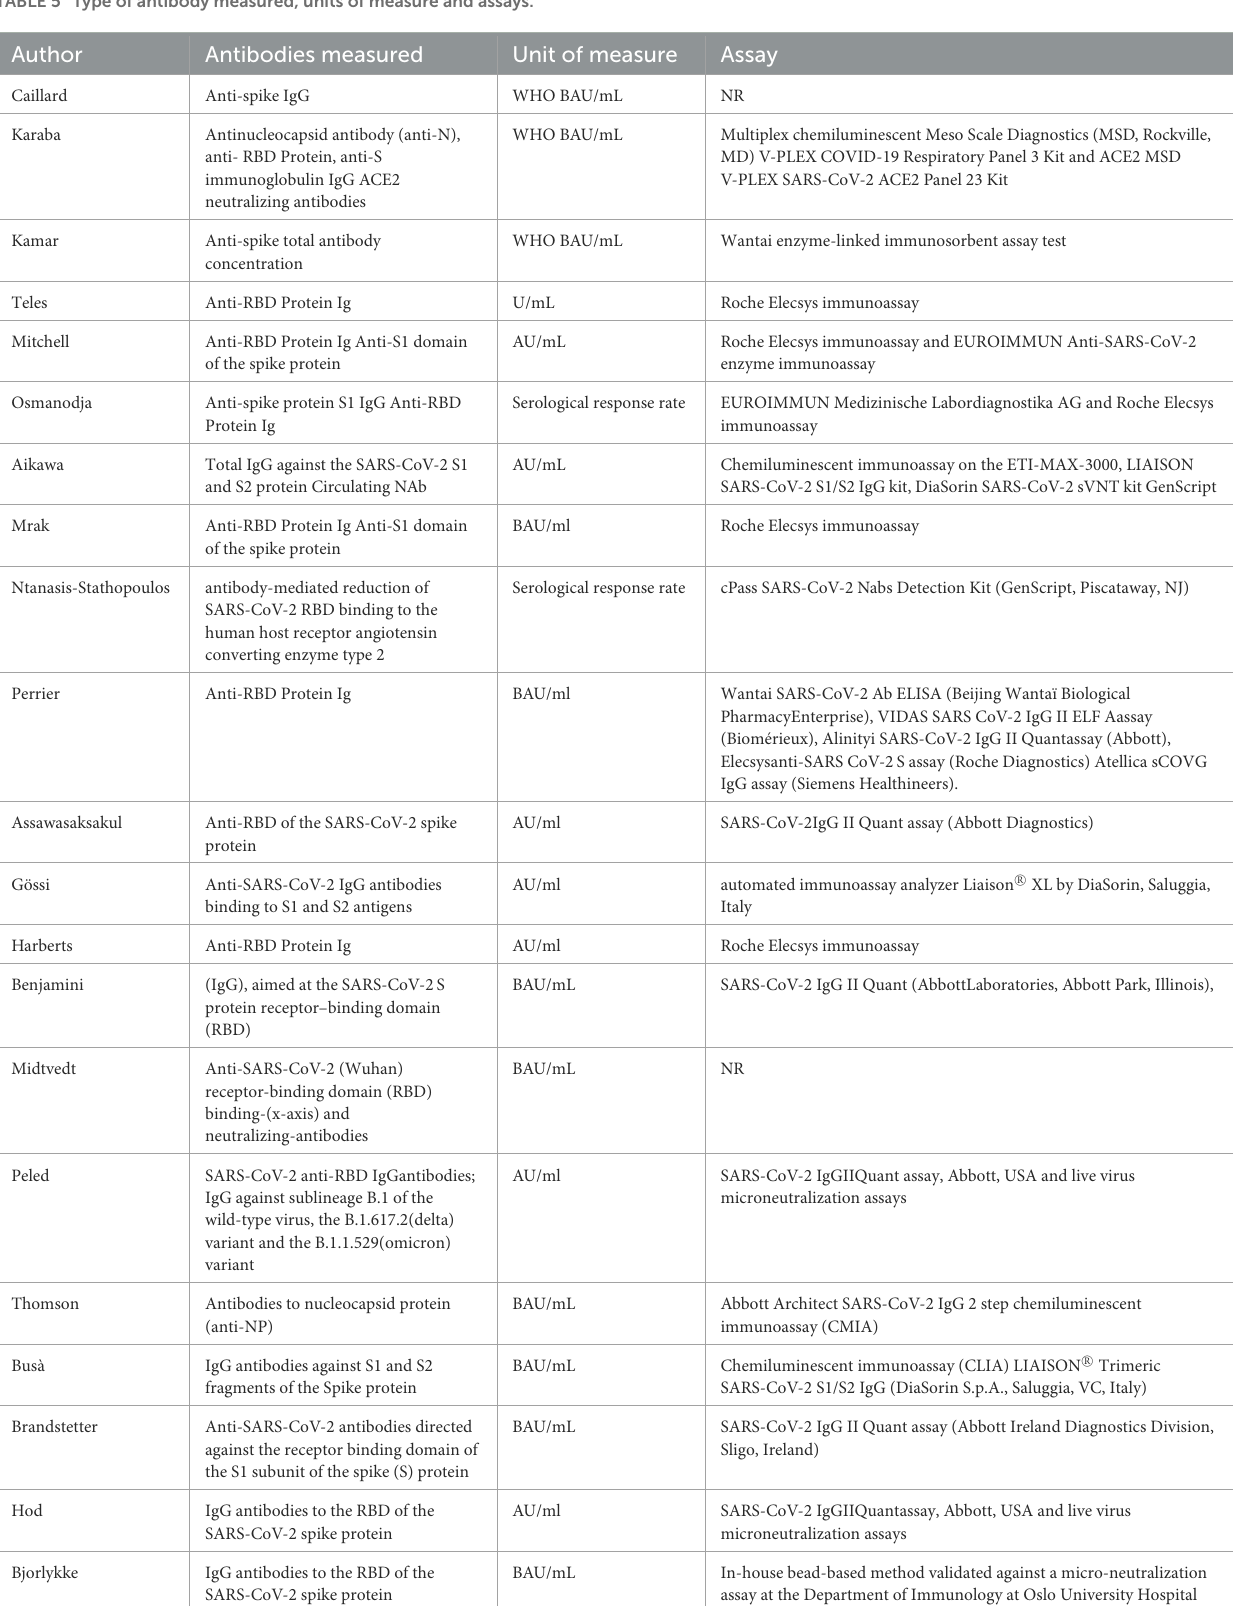
TABLE 5 Type of antibody measured, units of measure and